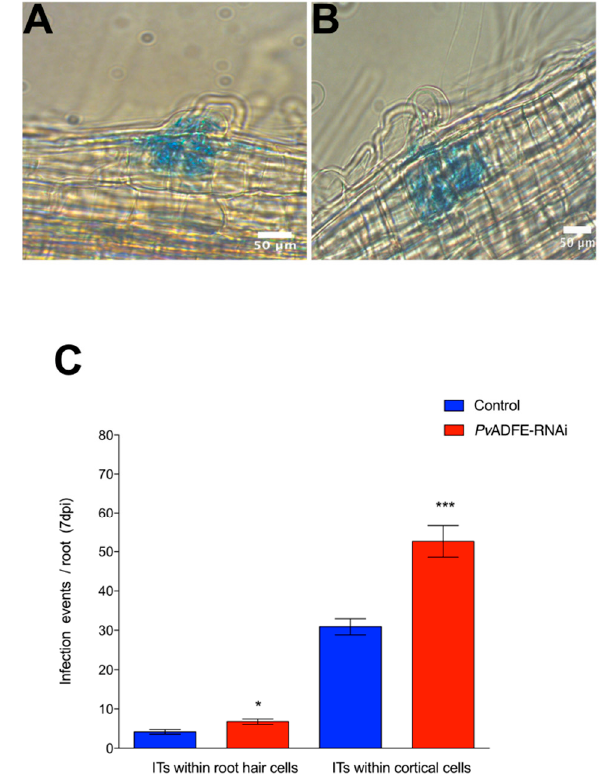
Figure 2. Analysis of infection events in root hairs of PvADFE -RNAi and control transgenic roots at 7 dpi with R. tropici expressing GUS. Micrographs show ( A ) branched infection threads (ITs) invading root cell layers in control transgenic roots and ( B ) ITs within the cortical cells in PvADFE -RNAi transgenic roots. ( C ) Number of infection events per root in PvADFE -RNAi and control transgenic roots at 7 dpi. Values are mean ± SEM with n > 9 roots per condition. * p < 0.05 and *** p < 0.005 according to Student’s t -test. Bars ( A , B ), 50 µ